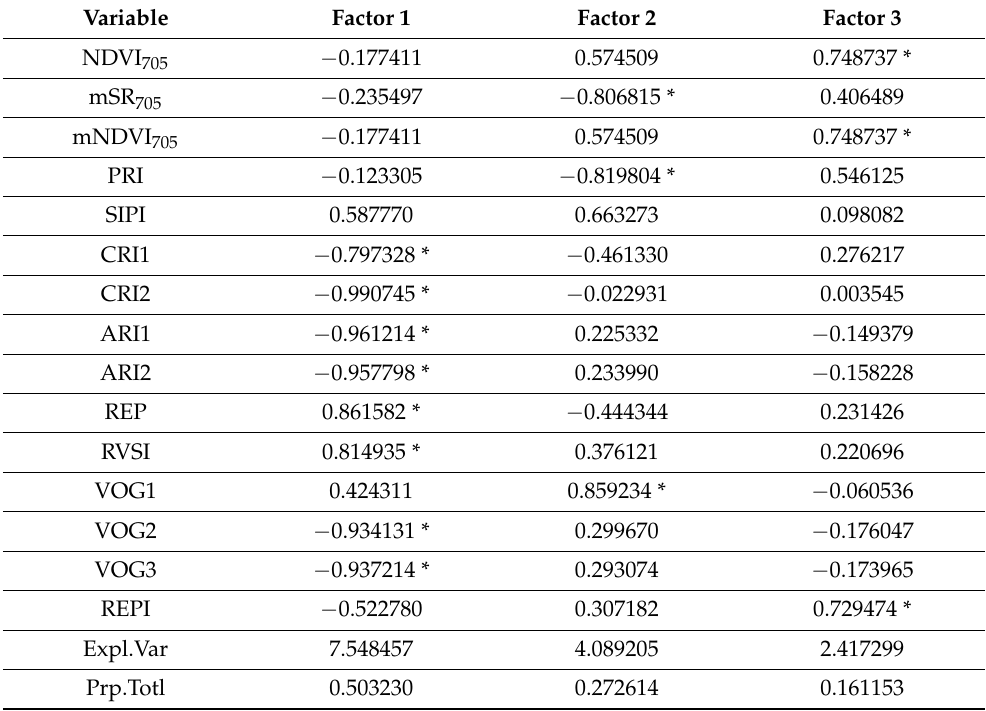
Table 3. Factor analysis results for variable index values.